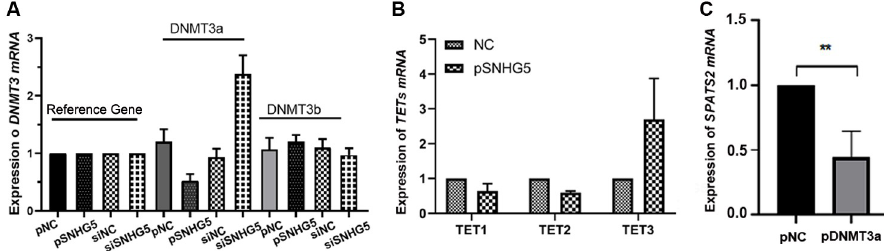
Fig 6. SNHG5 inhibits DNMT3a expression to up-regulate SPATS2. (A, B) RT-qPCR detected the relative expression of DNMT3a and TETs (TET1, TET2, TET3) in SNHG5-overexpression and downregulation HepG2 cells. (C) DNMT3a overexpression induces downregulation of SPATS2. The experiment was repeated three times, and a representative blot image is shown. � p < 0.05, �� p <